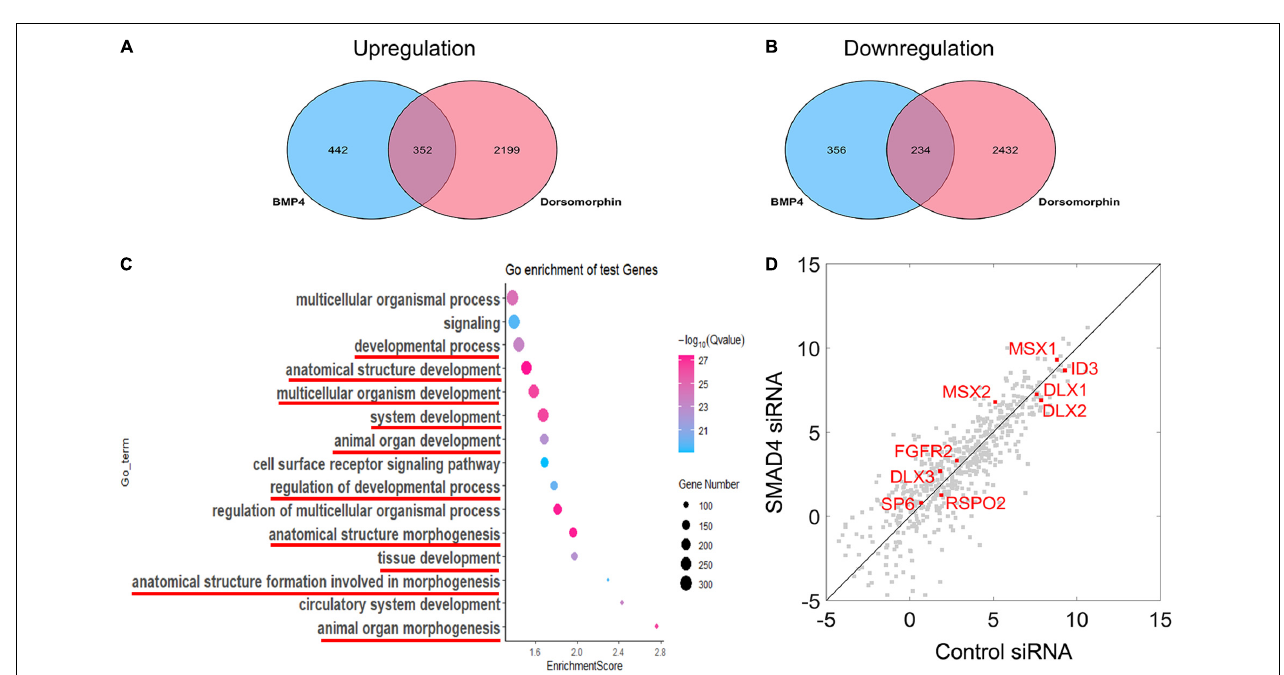
FIGURE 4 | Absence of pSMAD1/5/8-SMAD4 complex in the hDMCs. In situ proximity ligation assay (PLA) shows barely detectable pSMAD1/5/8-SMAD4 complexes (A) but abundant pSMAD2/3-SMAD4 complexes (B) in hDMCs. Bar = 50 µ m.